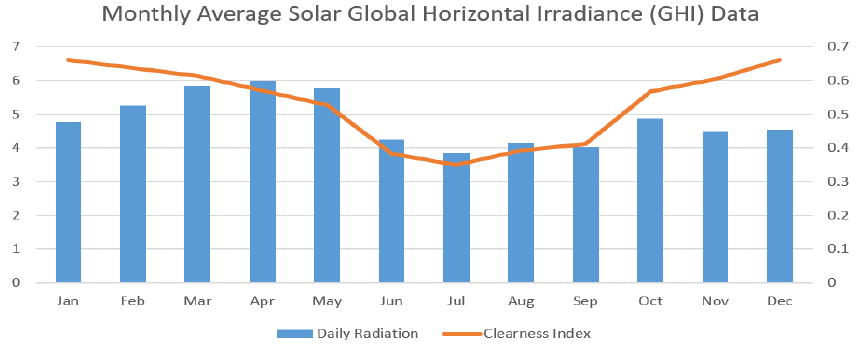
Figure 4. Solar radiation data in a year. Table 1. Estimated electricity demand for Kutubdia